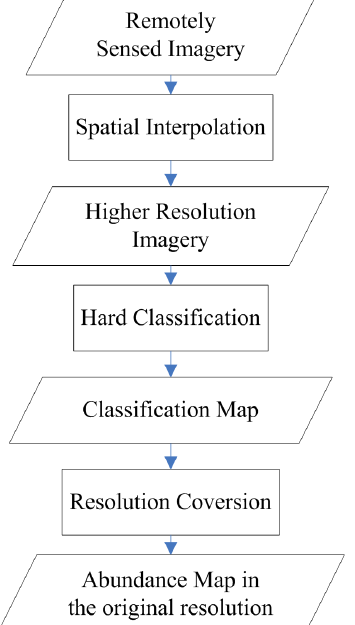
Figure 1. The flowchart of spatial interpolation-based spectral unmixing